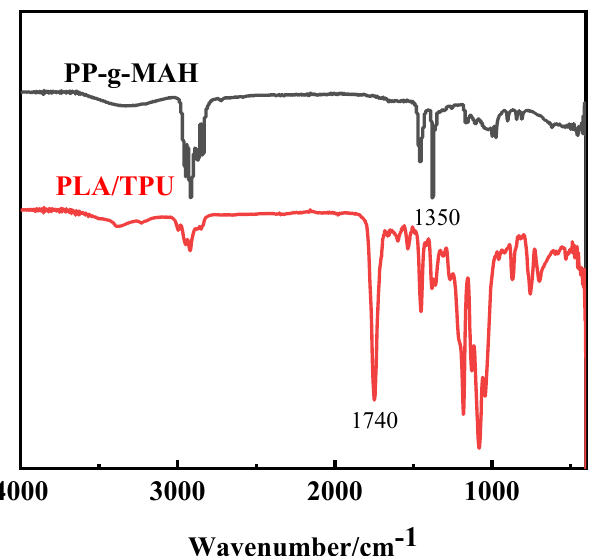
Figure 4. Infrared spectrum of PP- g -MAH and the